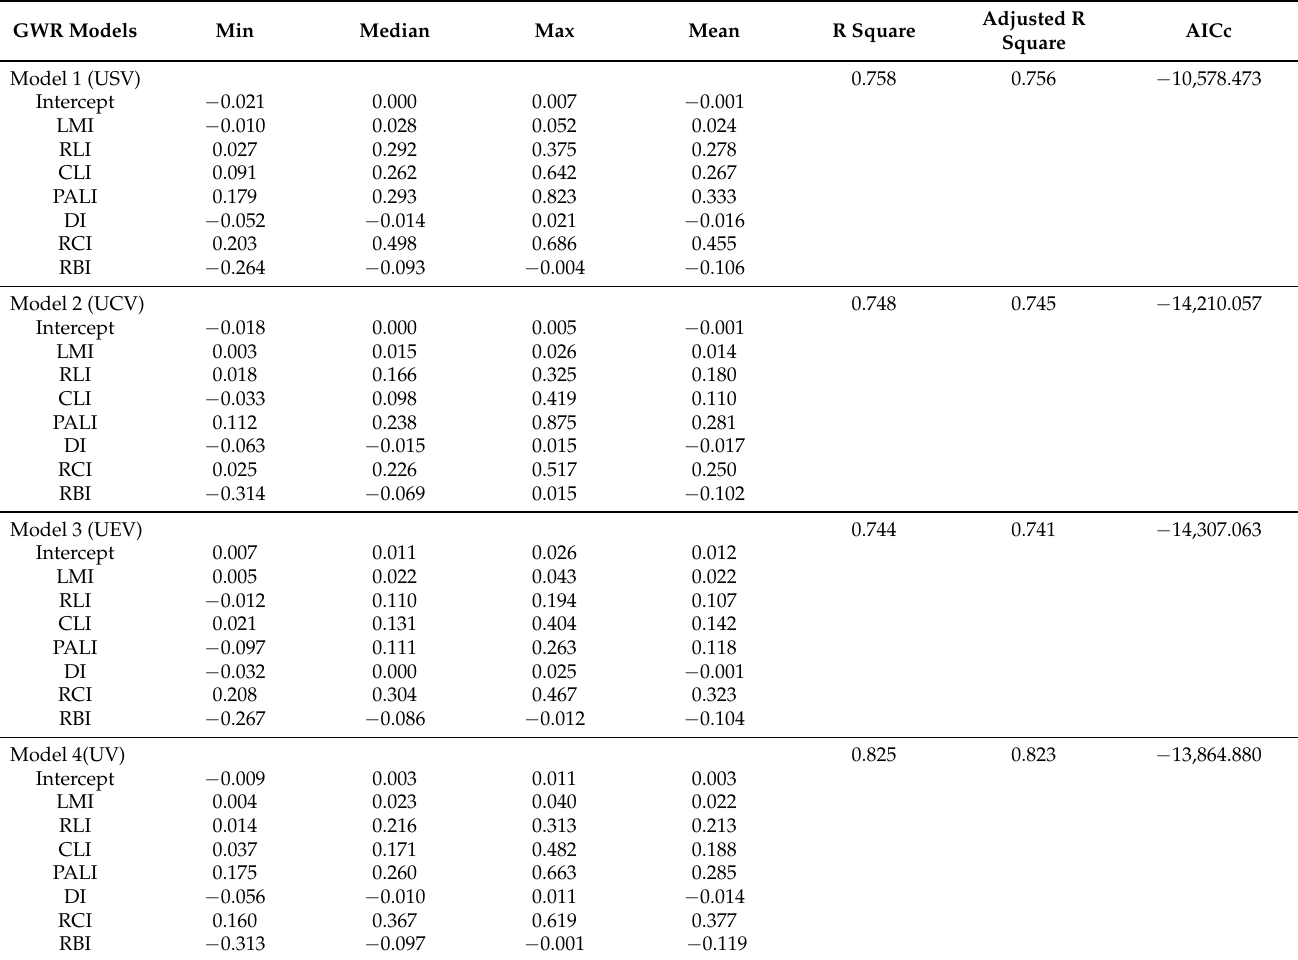
Table 3. The results for geographically weighted